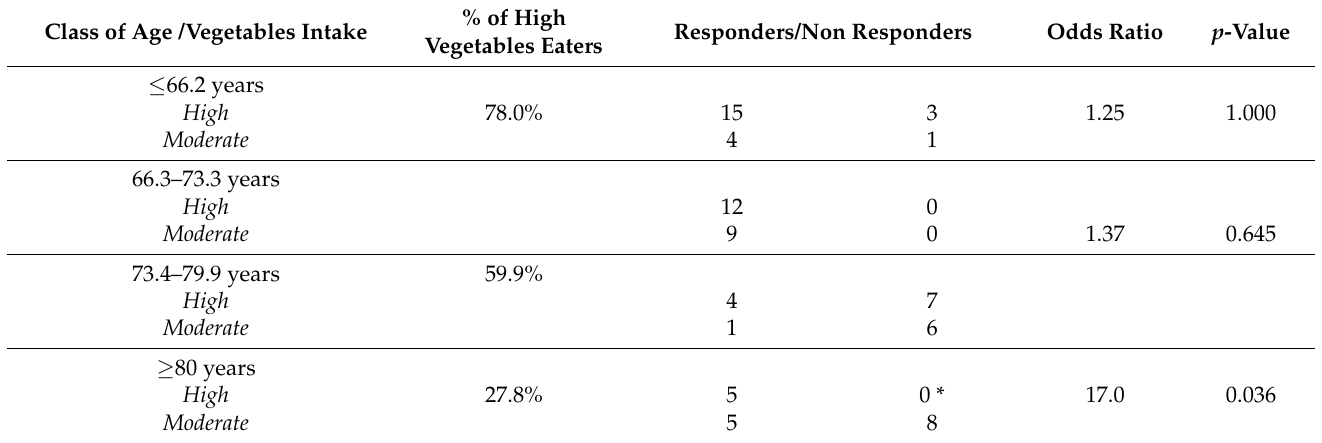
Table 5. Response to the treatment of COPD patients by vegetables intake and age-class. Class of Age /Vegetables